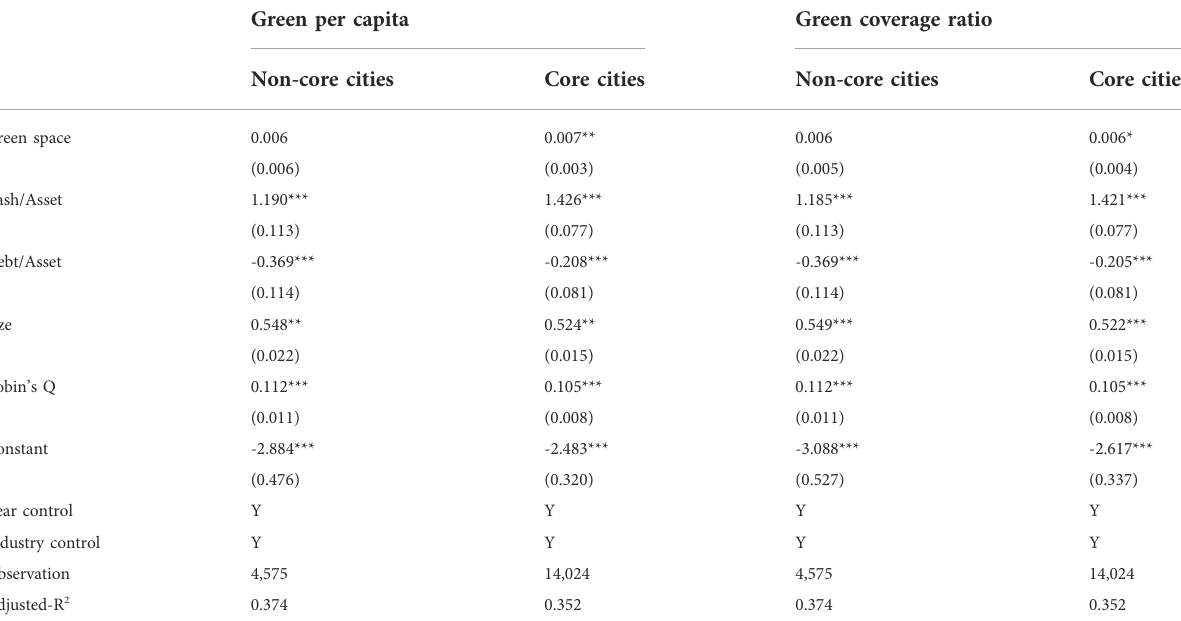
TABLE 8 Heterogeneity analysis based on